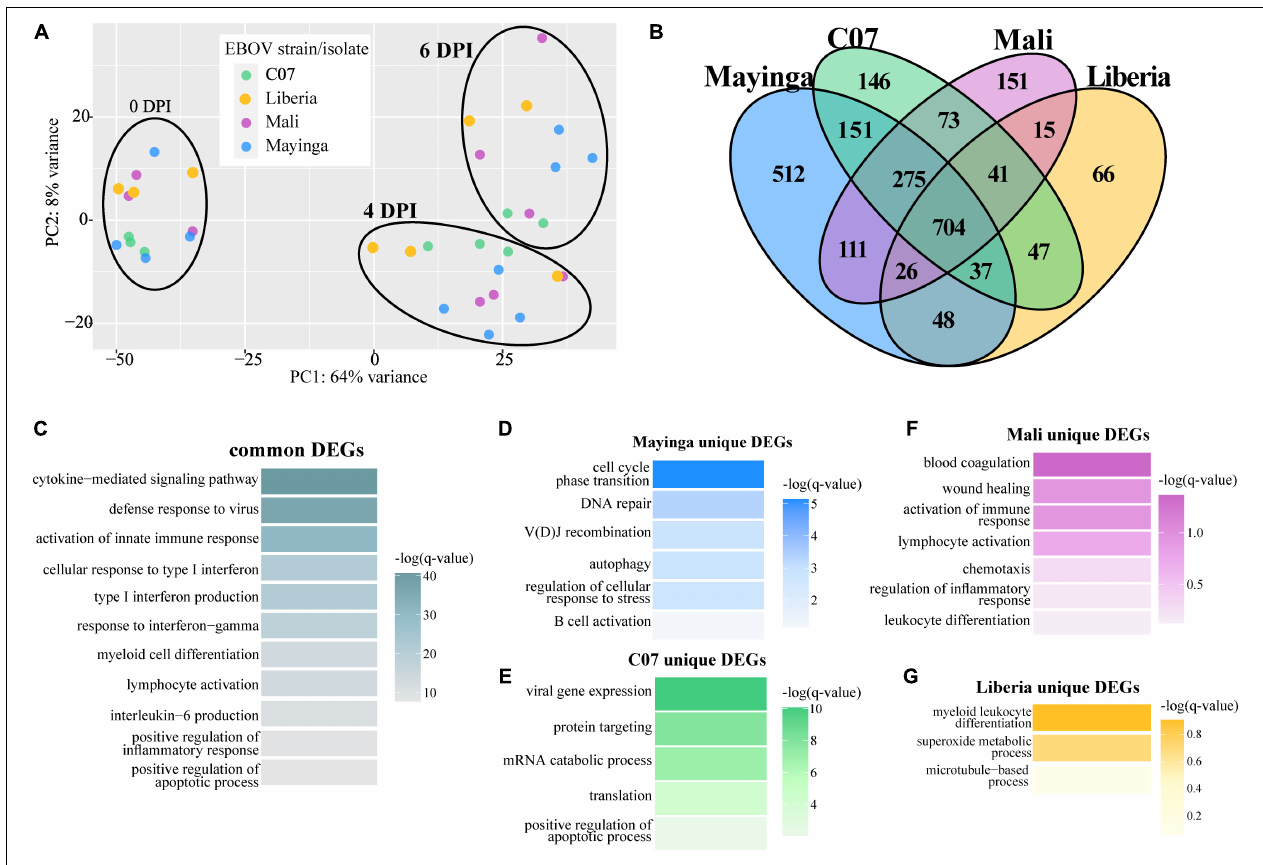
FIGURE 4 | Ebola virus-Makona and EBOV-Mayinga isolates share a core of DEGs related to EVD pathology. (A) Principal component analysis of normalized transcript counts at 0, 4, and 6 DPI for EBOV-Makona isolates and EBOV-Mayinga. (B) Four-way Venn diagram depicting overlaps between all up- and downregulated DEGs identified 4 and 6 DPI for all isolates. Functional enrichments for DEGs (C) common to all isolates or unique to (D) EBOV-Mayinga, (E) Guinea C07, (F) Mali, and (G) Liberia. Color indicates the –log( q -value) of each GO